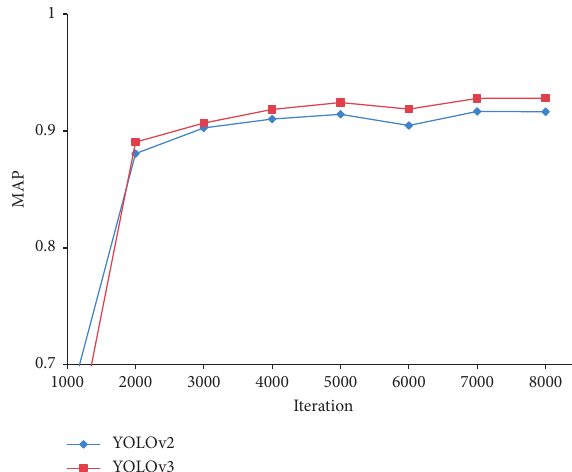
Figure 11: The comparison of mAP index between YOLOv2/v3 under the testing-set.